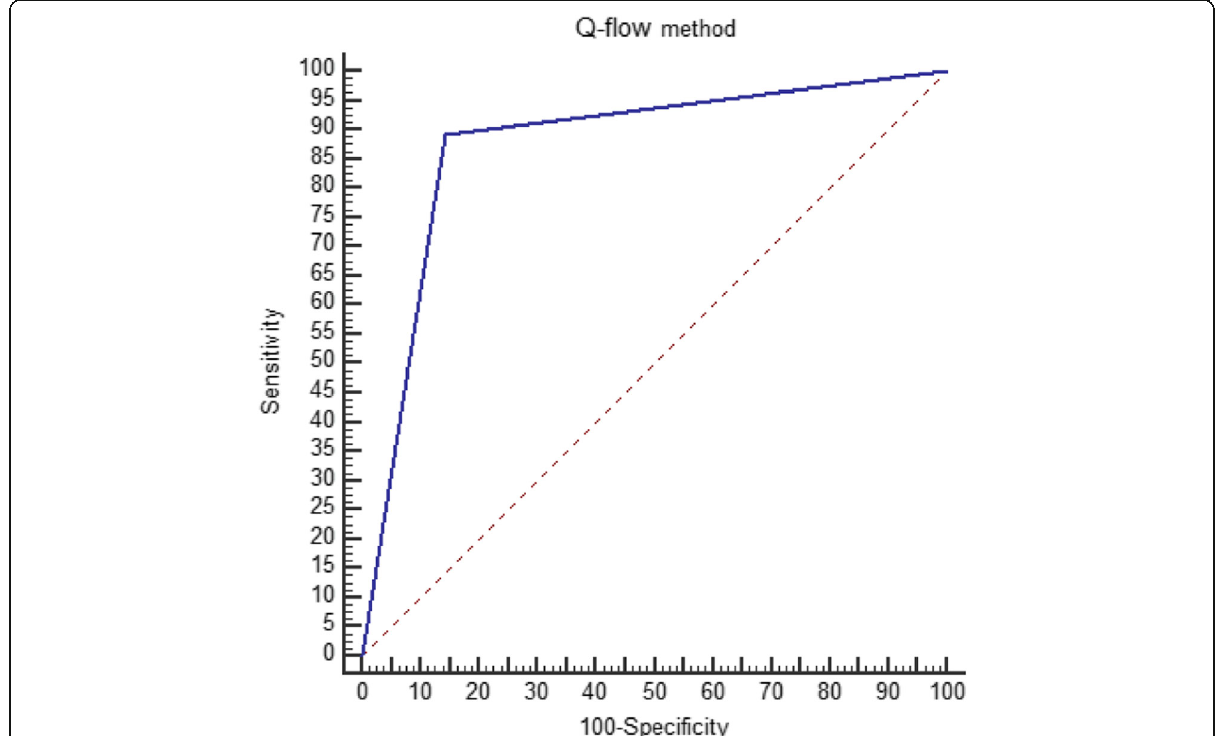
Fig. 3 Diagnostic accuracy of phase contrast (Q-flow) cardiac MRI in diagnosing impaired cardiac